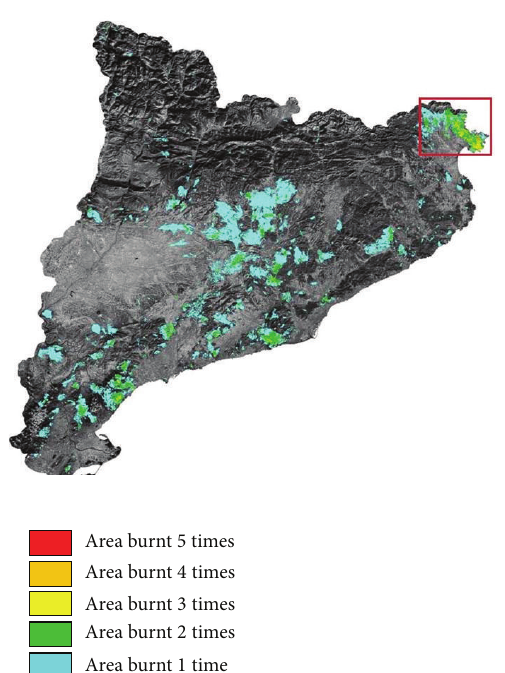
Figure3:FireoccurrencesinCataloniaintheperiod1975–2010(fire sizes bigger than or equal to